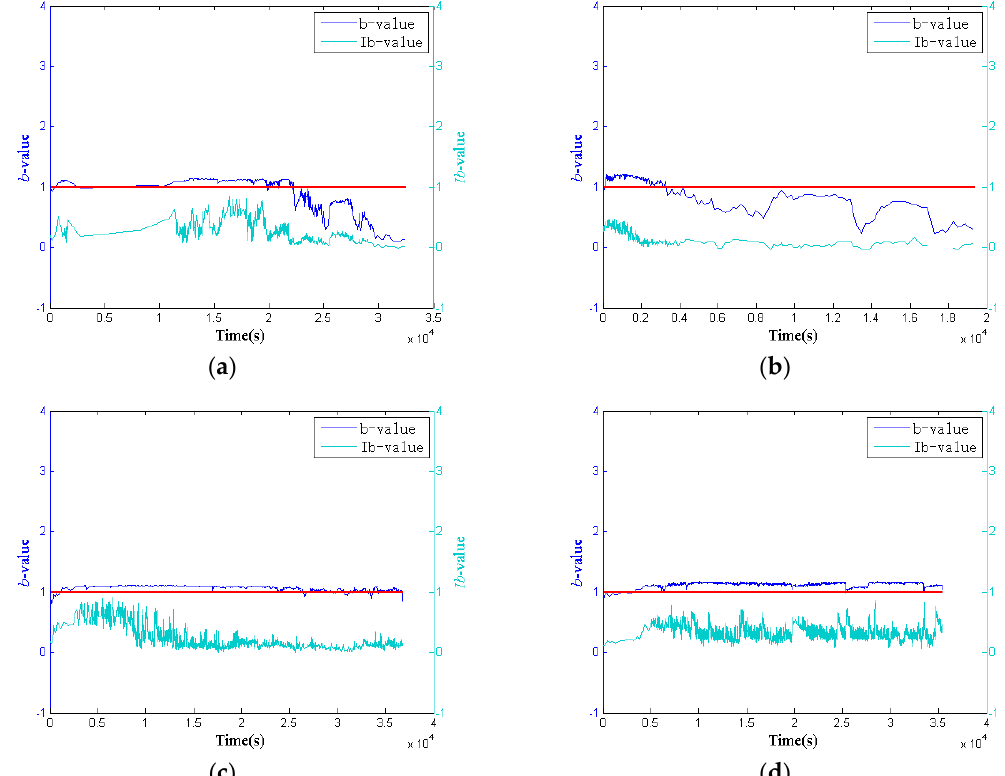
Figure 8. b -value and Ib -value of four specimens: ( a ) the first specimen; ( b ) the second specimen; ( c ) the third specimen; ( d ) the fourth specimen.